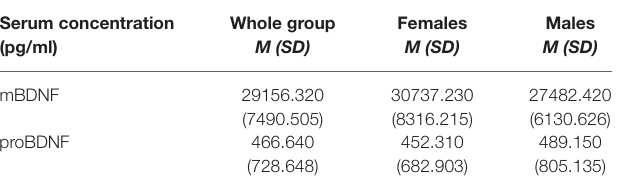
TABLE 4 | mature BDNF (mBDNF) and precursor BDNF (proBNDF) serum level in studied group. Serum concentration Whole group